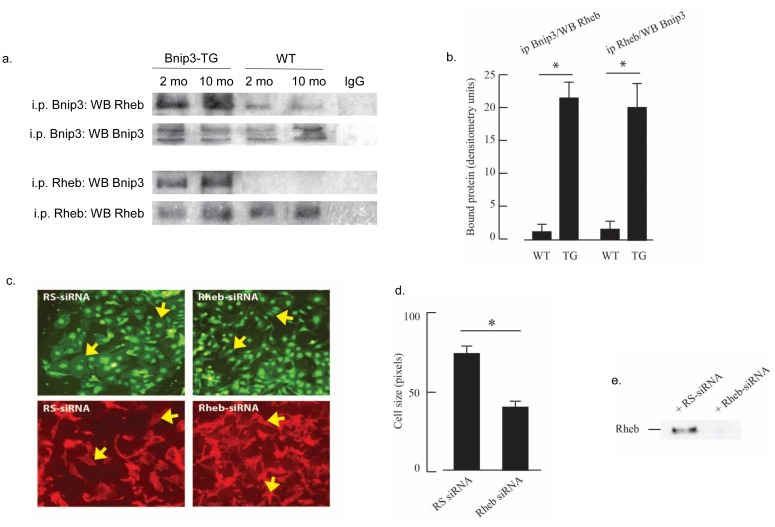
Rheb prevents cardiac hypertrophy and interacts with Bnip3.Myocardial lysates from Bnip3-TG and wild type (WT) mice were prepared and processed for reciprocal Bnip3 and Rheb immunoprecipitation as described in Methods. Representative western blots showing immunoprecipitation (i.p.) and western blot (WB) antibodies are shown in (A). Quantification of western blot immunoprecipitation is shown in (B) (n = 3; * p < 0.002). (C) Representative plates of neonatal rat cardiac myocytes after transfection with random sequence (RS) or Rheb siRNA and exposure to serum as a hypertrophy stimulus as described in Methods. Top panels GFP; bottom phalloidin (red); arrows indicate hypertrophied myocytes in RS panels and reduced myoplasm area with Rheb-siRNA treatment. (D) Quantification of cell area from ~100 myocytes per group as described in Methods (n = 3; * p < 0.002). (E) Representative western blot shown efficient KD of Rheb by siRNA. All results are mean ± S.E.M.